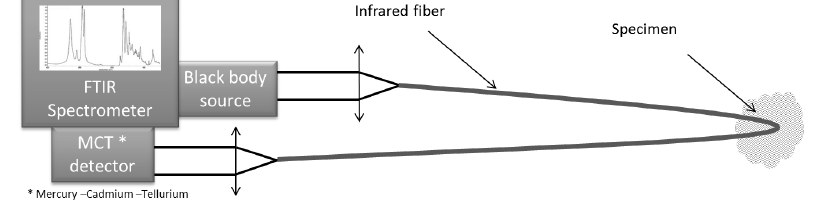
Figure 8. Principle of the fiber evanescent wave spectroscopy. The infrared light is focused at the input of the fiber and collected by the detector. The infrared signature of the analyzed specimen is recorded by applying it on the surface of the fiber.